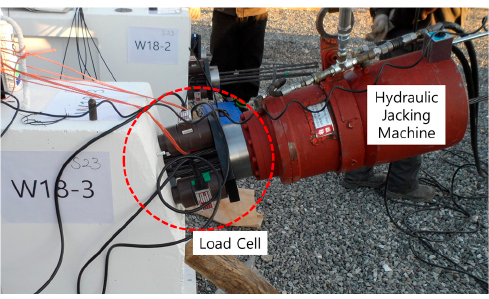
Figure 6. Installation of a load cell.